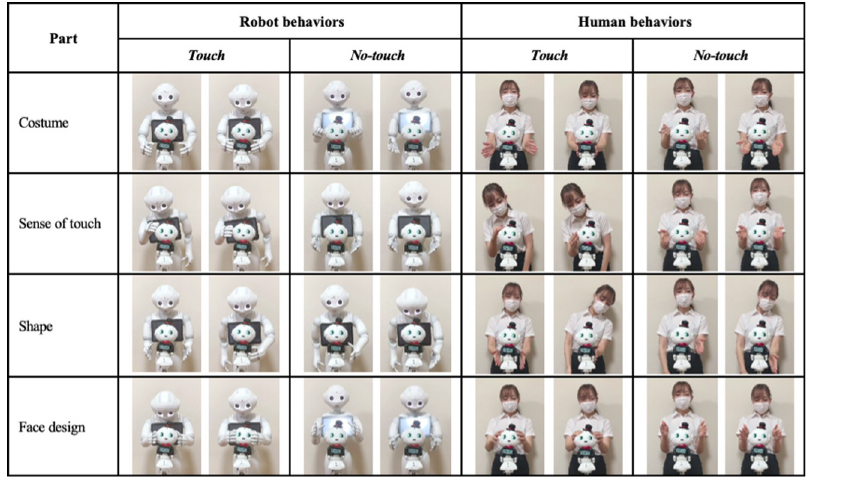
Fig 9. Presenter’s behaviors in each